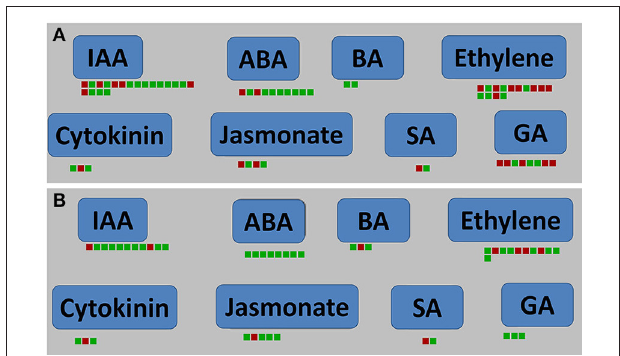
FIGURE 8 | Plant hormone signal pathway analyses of DEGs in A. thaliana during early infection by P. brassicae . Plant hormone signal pathway analyses were performed using MAPMAN software. Red boxes mean up-regulated genes and green mean down-regulated. (A) 24 h after inoculation; (B) 48 h after inoculation. The pathway frames are from the MAPMAN software